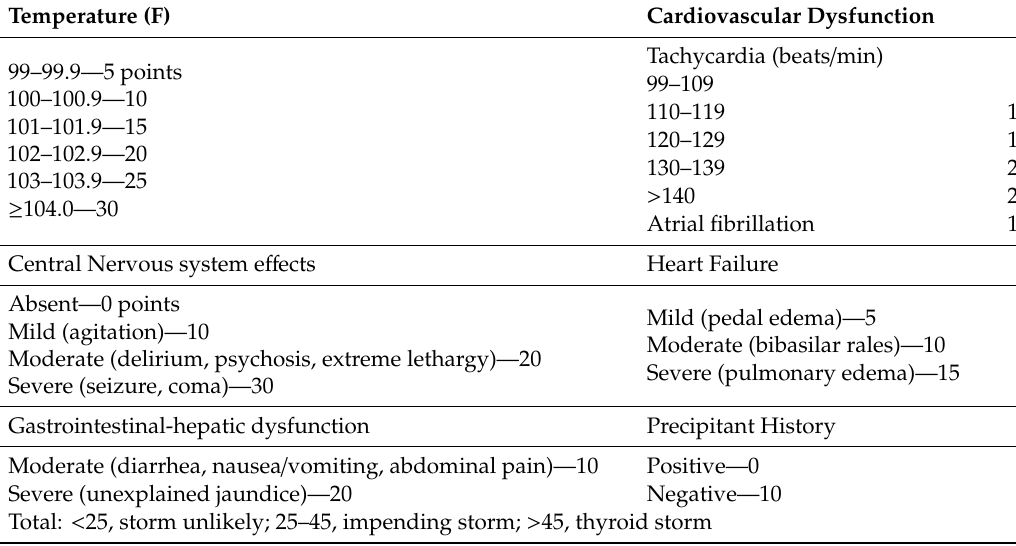
Table 4. Japan thyroid association definition and diagnostic criteria for thyroid storm